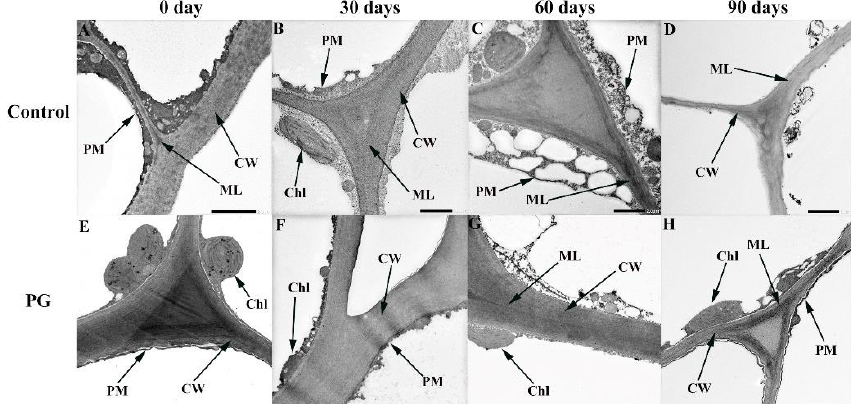
Figure 4. Effects of PG treatment on peel ultrastructure of winter jujube. Control ( A – D ), PG treatment ( E – H ). Stored for 0 d ( A , E ), stored for 30 d ( B , F ), stored for 60 d ( C , G ), stored for 90 d ( D , H ). Magnification: 3000, bar = 2.0 μm. Chloroplast (Chl), middle layer (ML), plasma membrane (PM), cell wall (CW).